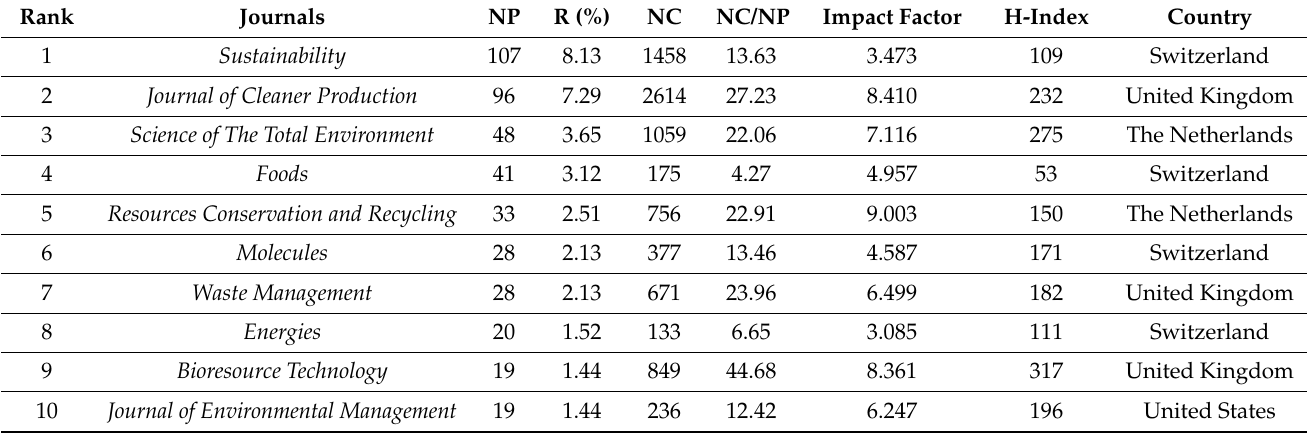
Table 4. Top 10 journals of publications on circular economy and foods during